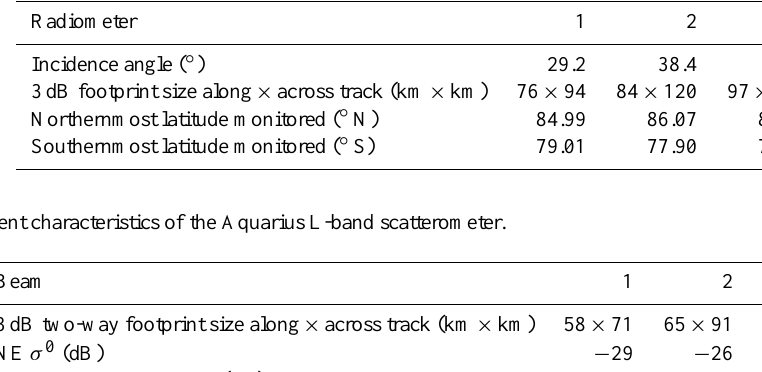
Table 1. Characteristics of the Aquarius L-band radiometers.